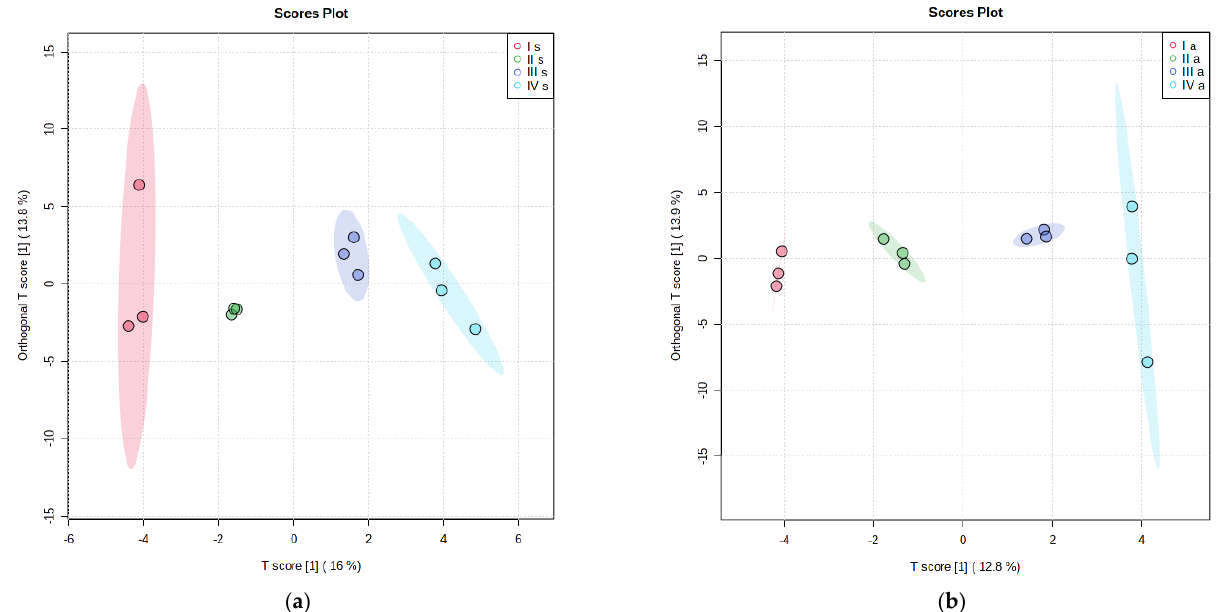
Figure 7. OPLSDA analysis of metabolite network of biolayers from Ruskeala quarry: ( a ) active vegetation stage; ( b ) late vegetative stage.